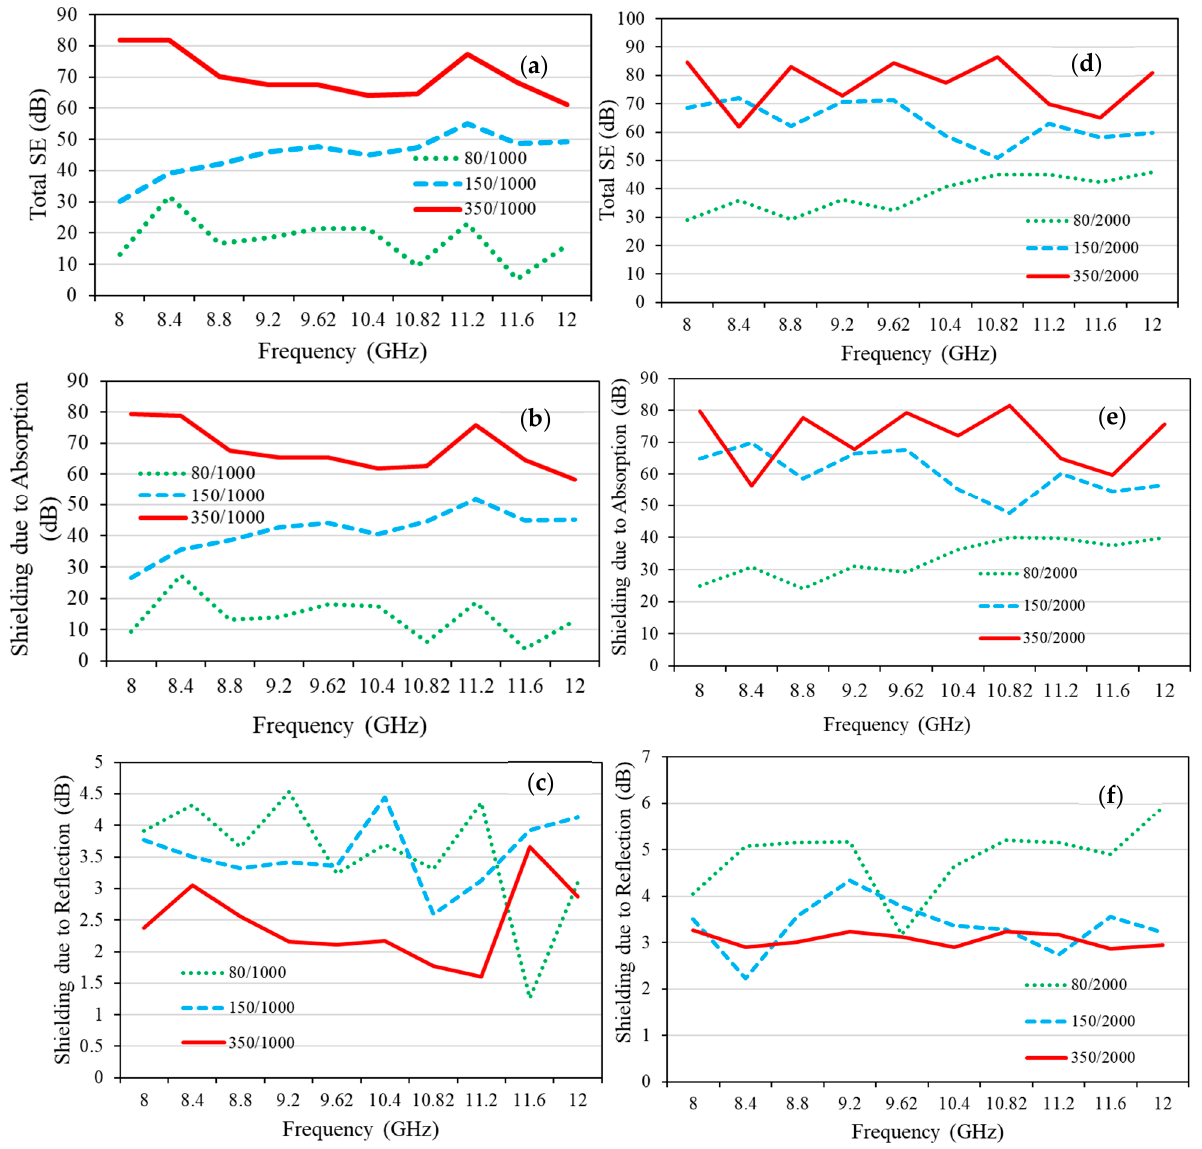
Figure 5. Shielding effectiveness of composites with Fe 3 O 4 nano particles of 1.0 wt.% and carbon fibers with fiber density of 1000 fibers/mm 2 ( a ) total SE, ( b ) absorption SE, and ( c ) reflection SE; carbon fibers with fiber density of 2000 fibers/mm 2 ( d ) total SE, ( e ) absorption SE, and ( f ) reflection SE.